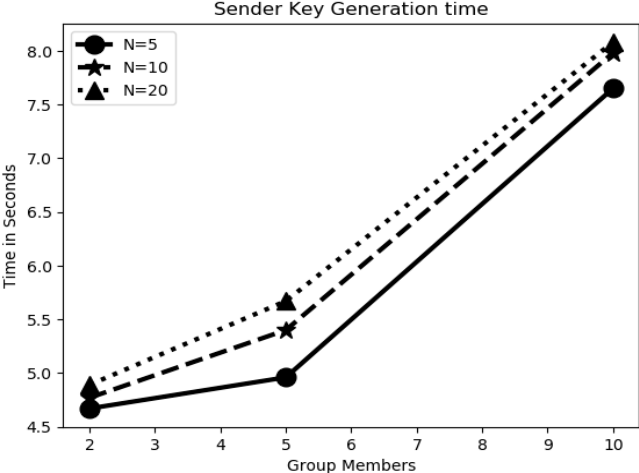
Figure 6. Key-generation time among multi-agents/stake holders.